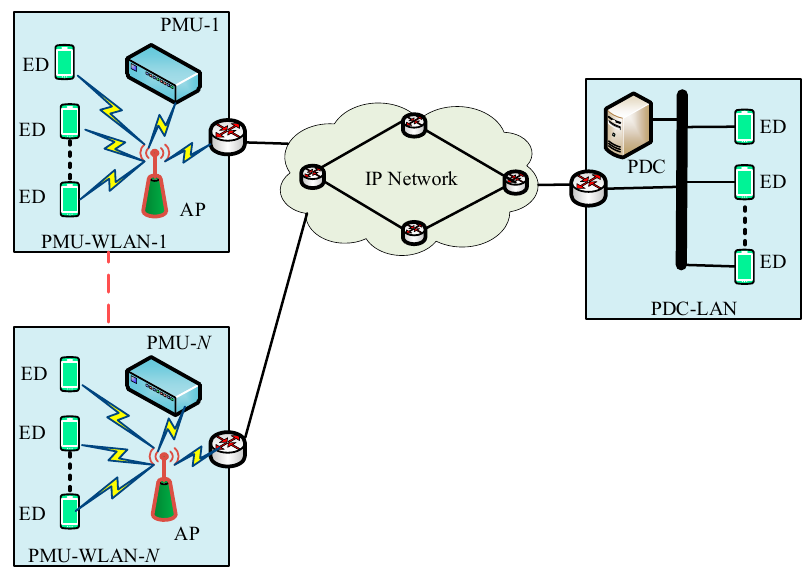
Figure 3. Hybrid synchrophasor communication network.